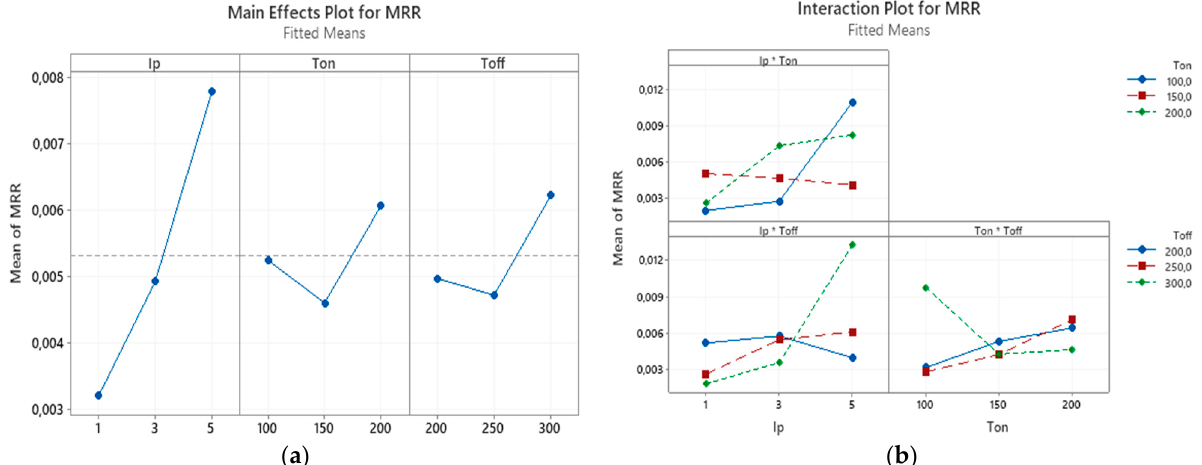
Figure 8. ( a ) The main effects plot and ( b ) the interaction effects plot for the